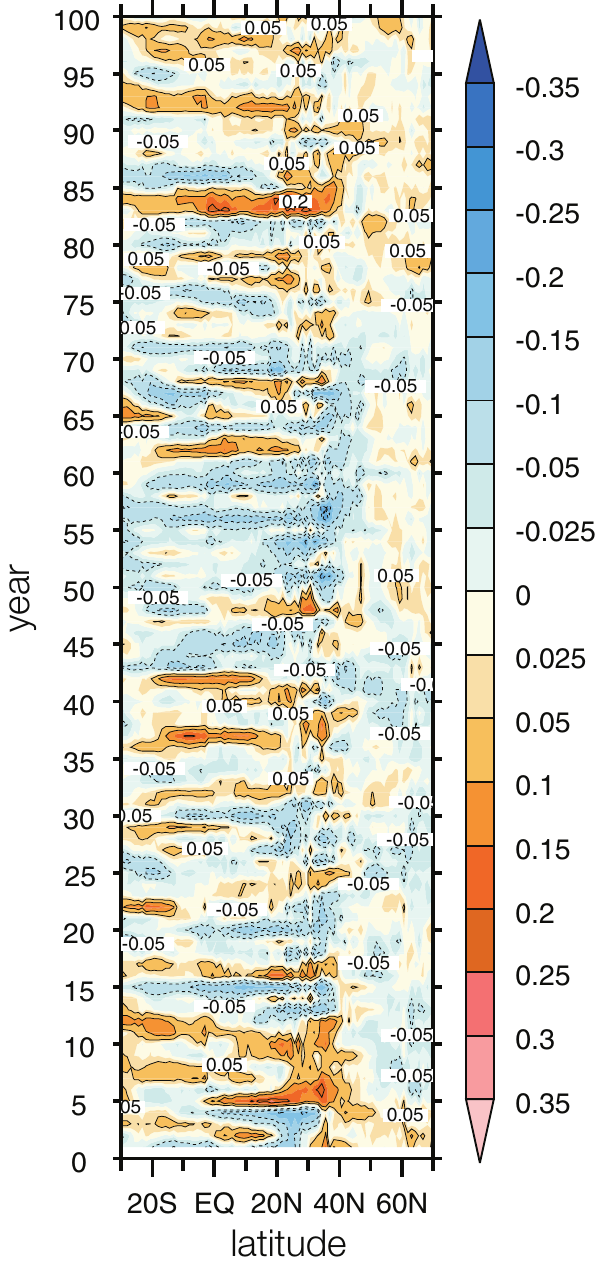
Fig. 1. Latitude-time evolution of the ocean heat trans- port anomalies (PW: 10 15 W) in the Atlantic for the HadCM3 simulation. Positive anomalies are in full lines and negative ones in dashed